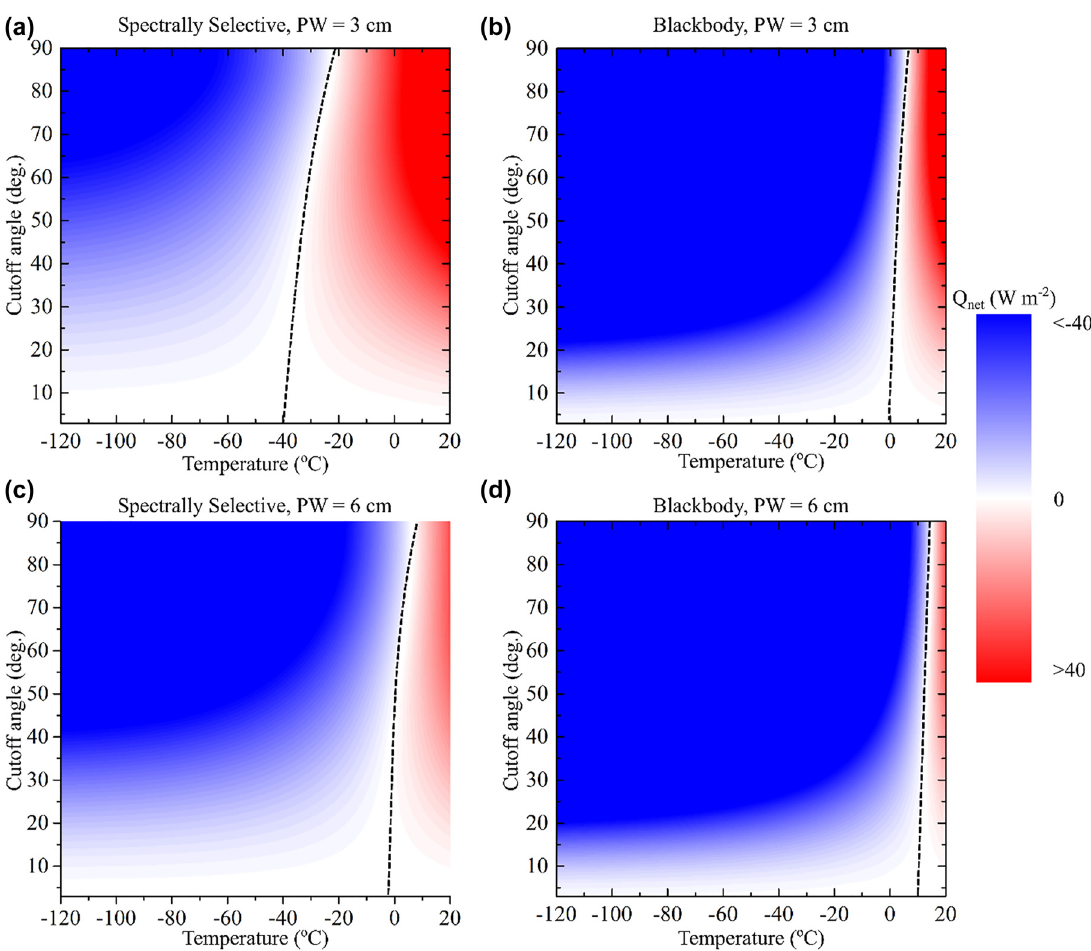
Figure 3: Effect of humidity on the performance of angularly selective thermal emitter. For spectrally selective emitter, subfreezing temperatures are attainable for all angles at (a) 3 cm precipitable water (PW) level for all angles, and (c) for a cutoff angle < 30 ◦ for a PW level of 6 cm. For a blackbody, angular selectivity can improve the emitter performance slightly but subfreezing temperatures are not possible at any cutoff